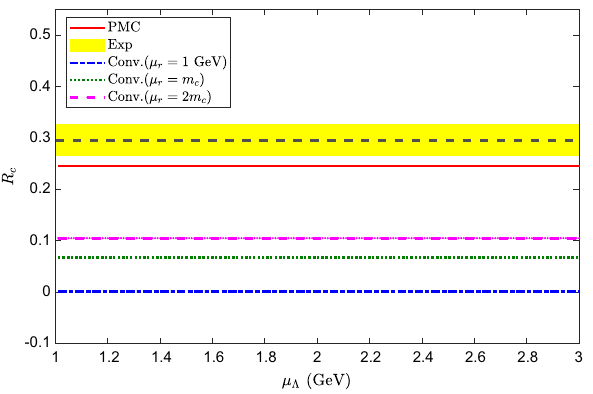
Fig. 3 The NNLO R c -ratio versus the factorization scale μ (cid:12) under conventional and PMC scale-setting approaches. Three typical μ r are adopted, and the PMC prediction is independent to those choices of μ r . The shaded band represents the BESIII data [4] with the dashed line being its central